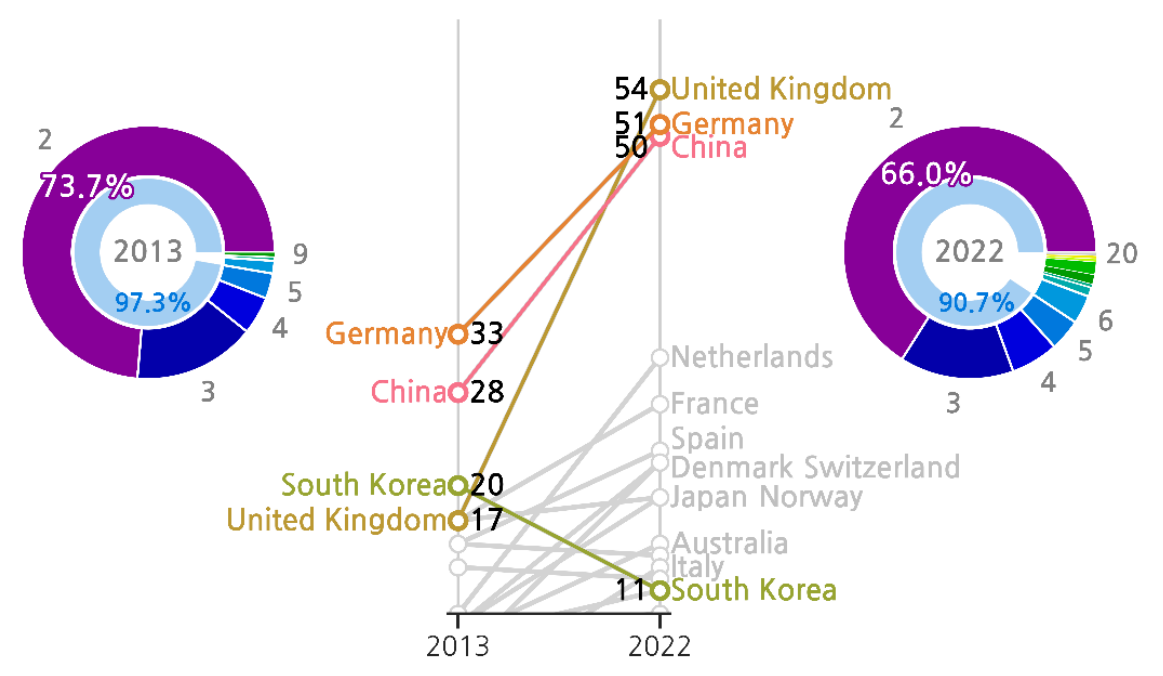
Figure 6. Change in the number of co-authored publications by country between 2013 and 2022. Not all country names are displayed to avoid overlapping, particularly in 2022. Inset donut charts represent the proportions of publications by international collaboration. The number of co-authored countries is, attached next to the corresponding wedges; some annotations are omitted for better visualization of the maximum number.